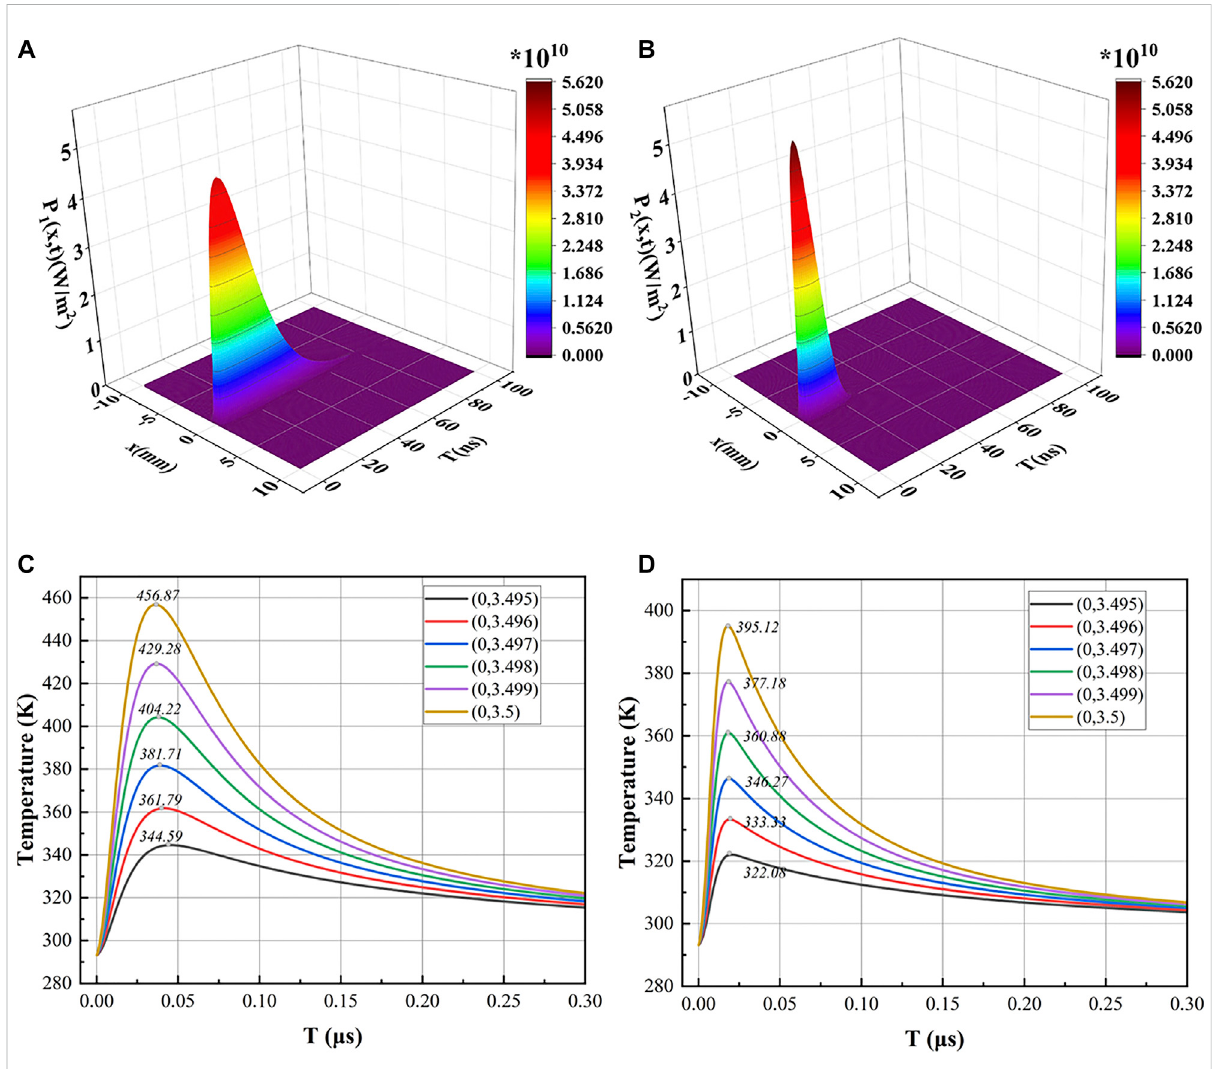
FIGURE 2 Gaussian pulse and temperature fi eld of different time functions: (A) Gaussian pulse of time function g 1 ; (B) Gaussian pulse of time function g 2 ; (C) Temperature fi eld of time function g 1 ; (D) Temperature fi eld of time function g 2